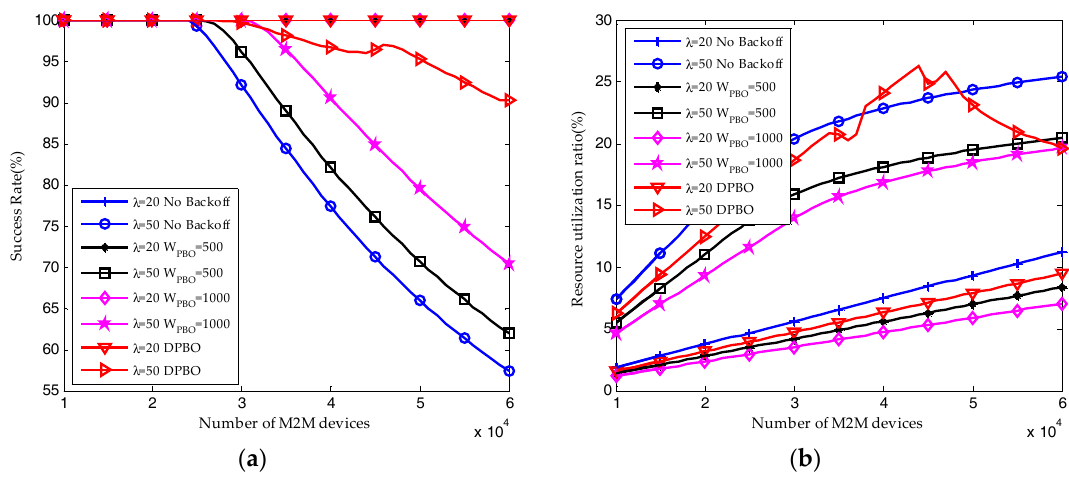
Figure 12. Performance results of HSTMAC protocol with dynamic pre-backoff scheme (Q = 10, W BO = 20): ( a ) Average success probability of M2M traffic; ( b ) Average resource utilization ratio of M2M traffic.